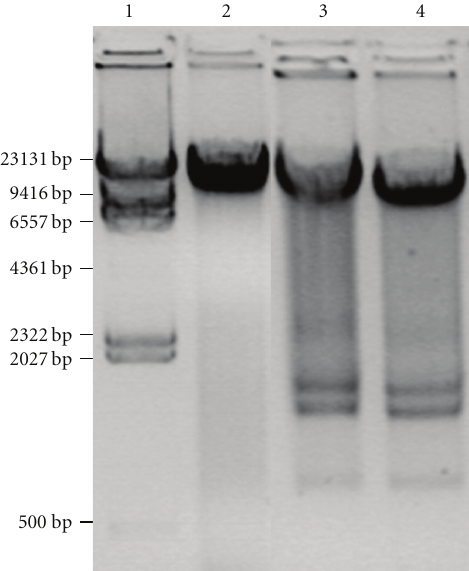
Figure 4: Analysis on 1% (w/v) agarose gel of HeLa genomic DNA profiling. Legend: (1) λ / HindIII molecular weight marker; (2) genomic DNA of untreated cells; (3) and (4) genomic DNA of cells treated for 24 h with n-frutalin and r-frutalin (both at 100 μ g/mL),